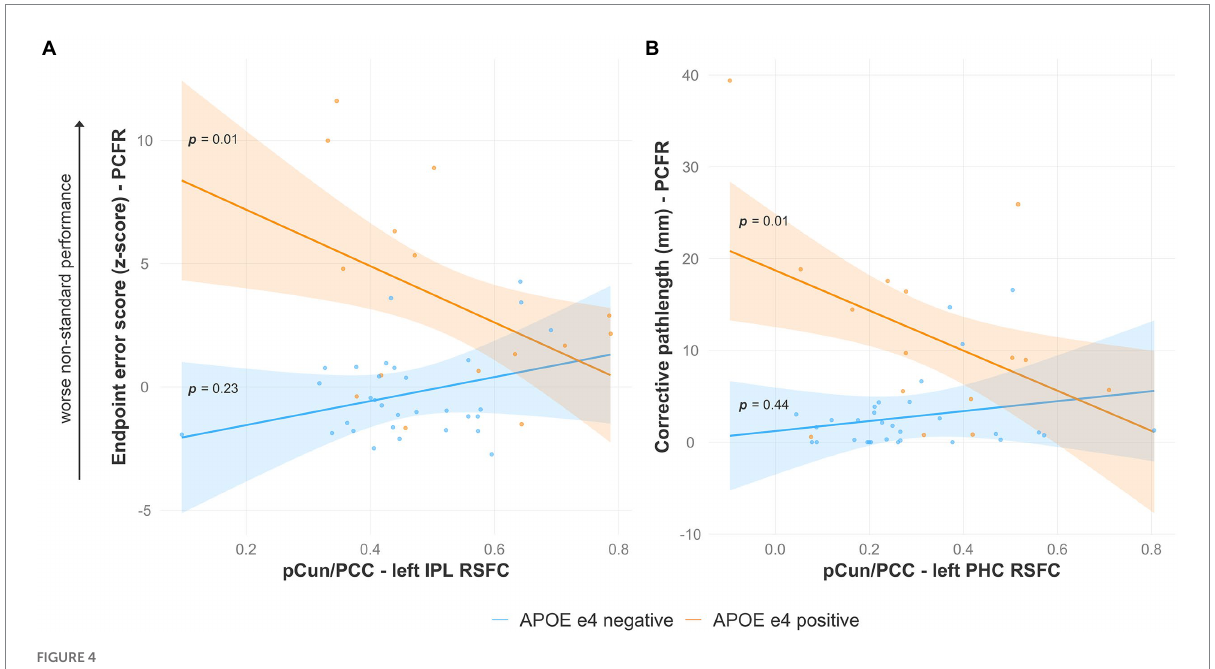
FIGURE 4 Lower RSFC between several DMN nodes predicts worse visuomotor performance (reflected by higher endpoint error scores or corrective path lengths) in the plane-change feedback reversal condition only in APOE ε 4 carriers. Specifically, lower RSFC between the (A) pCun/PCC and left IPL, and (B) pCun/PCC and left PHC predicts worse non-standard visuomotor performance. Significant results shown from multiple regression and simple slopes analyses. RSFC, resting state functional connectivity; APOE , apolipoprotein E; pCun/PCC, precuneus/posterior cingulate cortex; IPL, inferior parietal lobule; PHC, parahippocampal cortex; PC + FR, plane change feedback reversal